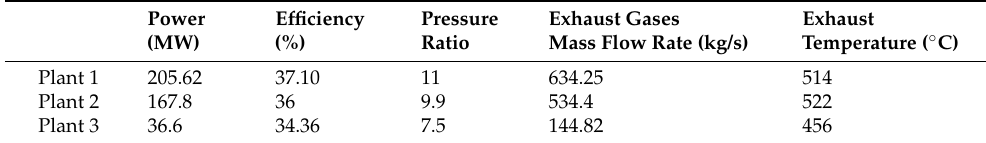
Table 2. Performance specifications of the selected plants.